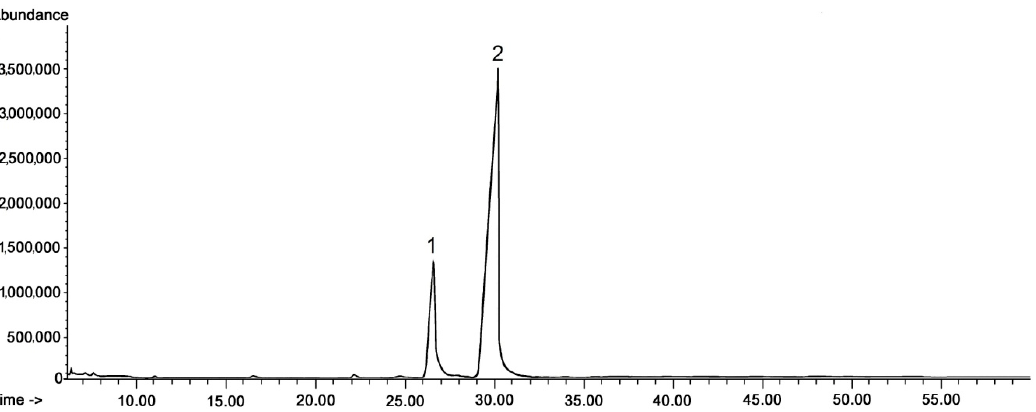
Figure 2. GC-FID chromatograms of the fraction of methylated triterpenoid acids obtained from chloroform extracts of cuticular waxes of lingonberry fruit harvested in July. Methyl esters of: 1—oleanolic acid, 2—ursolic acid.